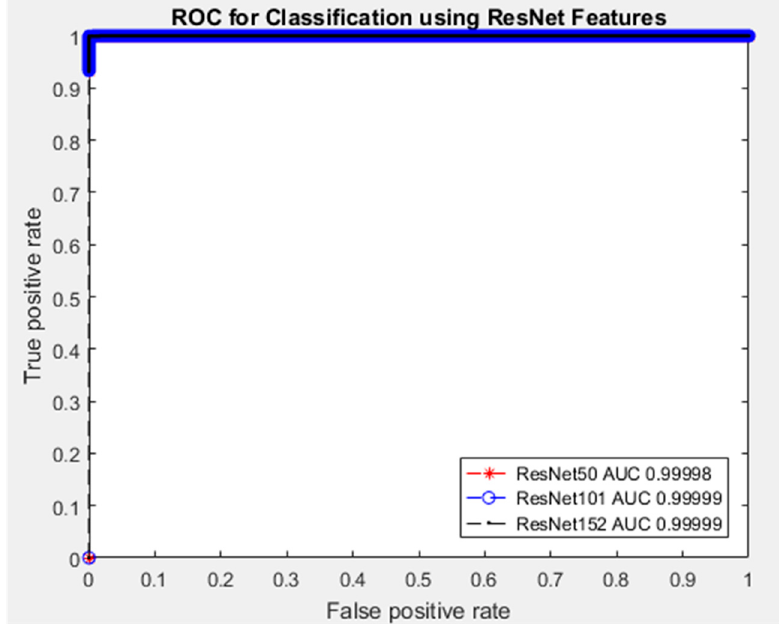
Figure 14. Receiver Operating Characteristic (ROC) curve for the binary classification of Burns and PUB.